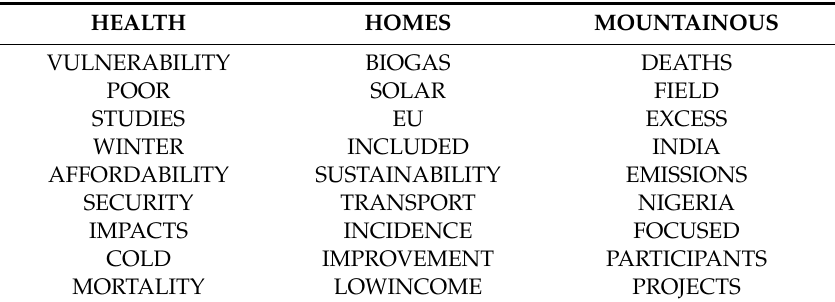
Table A7. Most important (relevant and frequent) words.